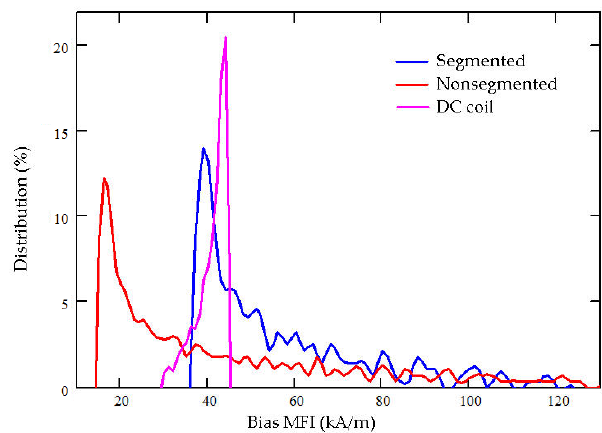
Figure 7. Bias magnetic field distribution within the Terfenol-D rod for three configurations.